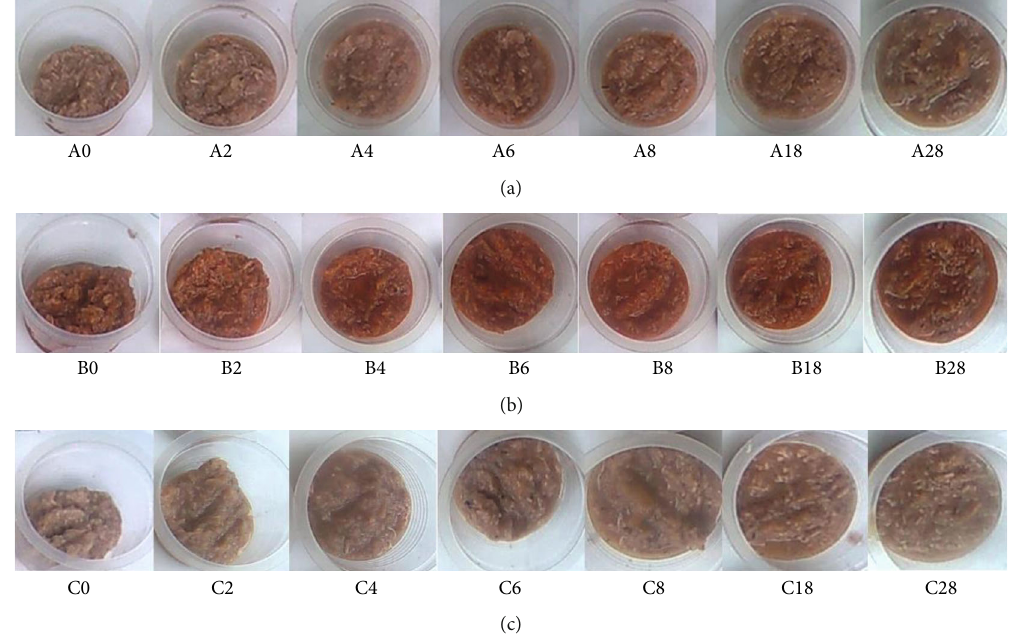
Figure 2: The appearance of cincalok: (a). recipe A; (b). recipe B; (c). recipe C. The number showed the fermentation time (day).